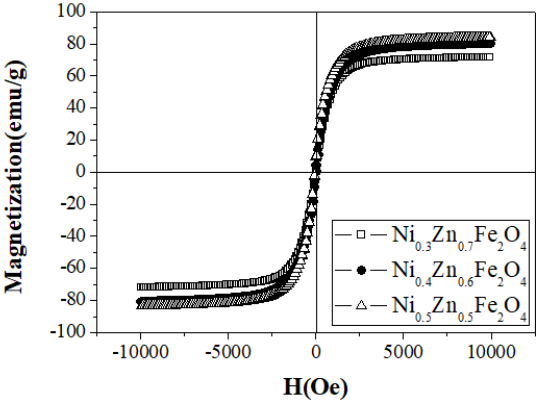
Figure 6. Hysteresis curves of Ni 1 − x Zn x Fe 2 O 4 (x = 0.5, 0.6, 0.7) ferrite nanoparticles.